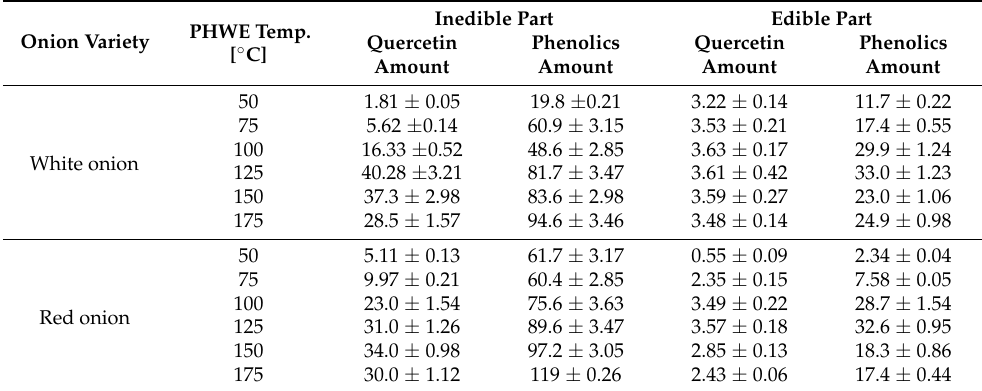
Table 2. Concentration of quercetin and the total phenolics amount in PHWE extracts obtained in the range of 50–175 ◦ C from the edible and inedible parts of white and red onions. PHWE Temp. Onion Variety [ ◦ C]